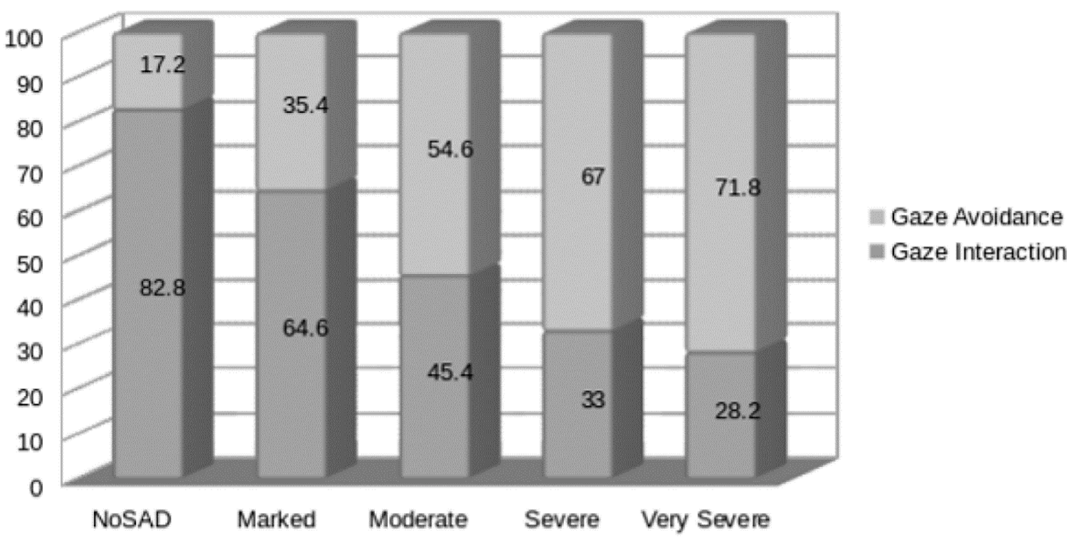
Figure 7. Relationship between SAD and the gaze interaction of male participants. Figure 7. Overall view of gaze interaction and SAD relationship.